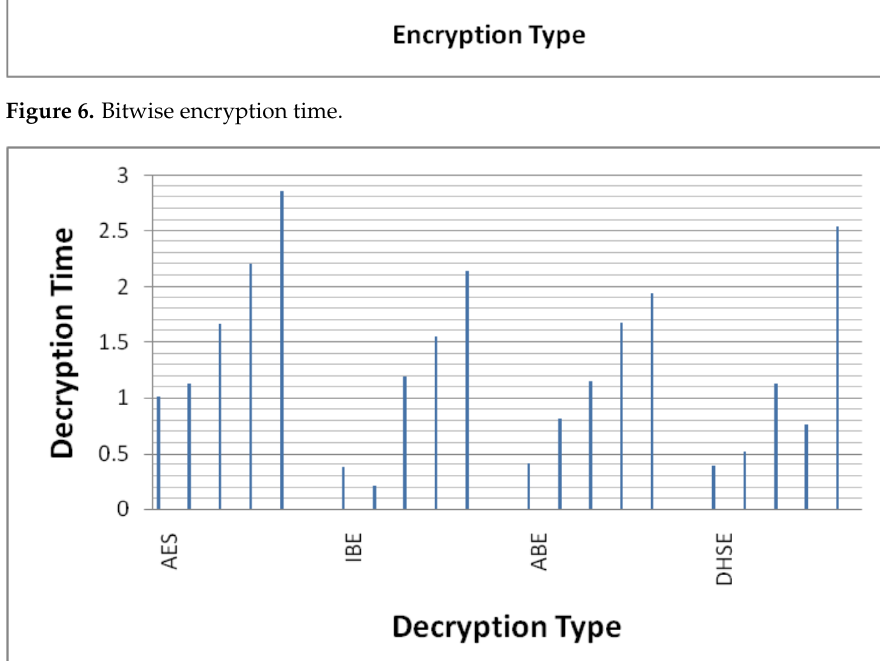
Figure 7. Bitwise decryption